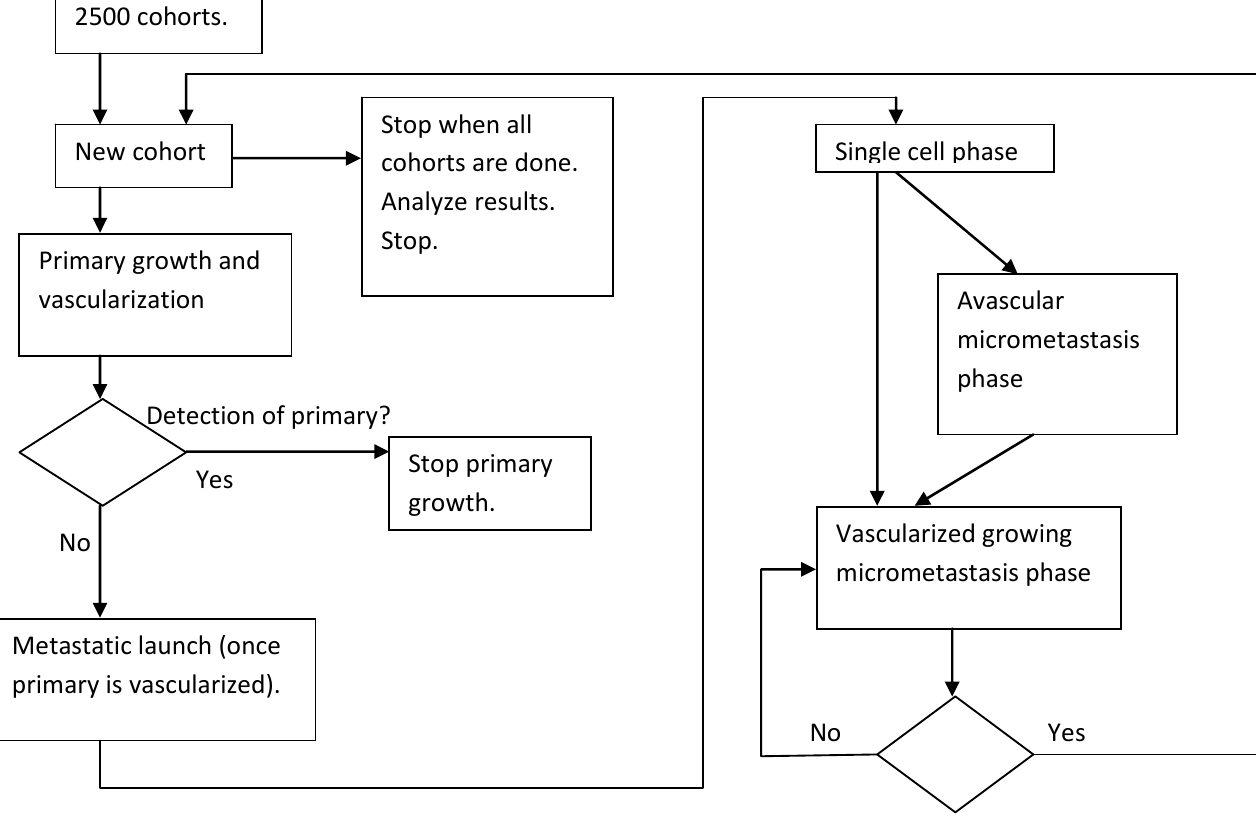
Figure 3. The computer program that was used to determine numerical values of growth rates and transitions from dormancy is shown in flow chart